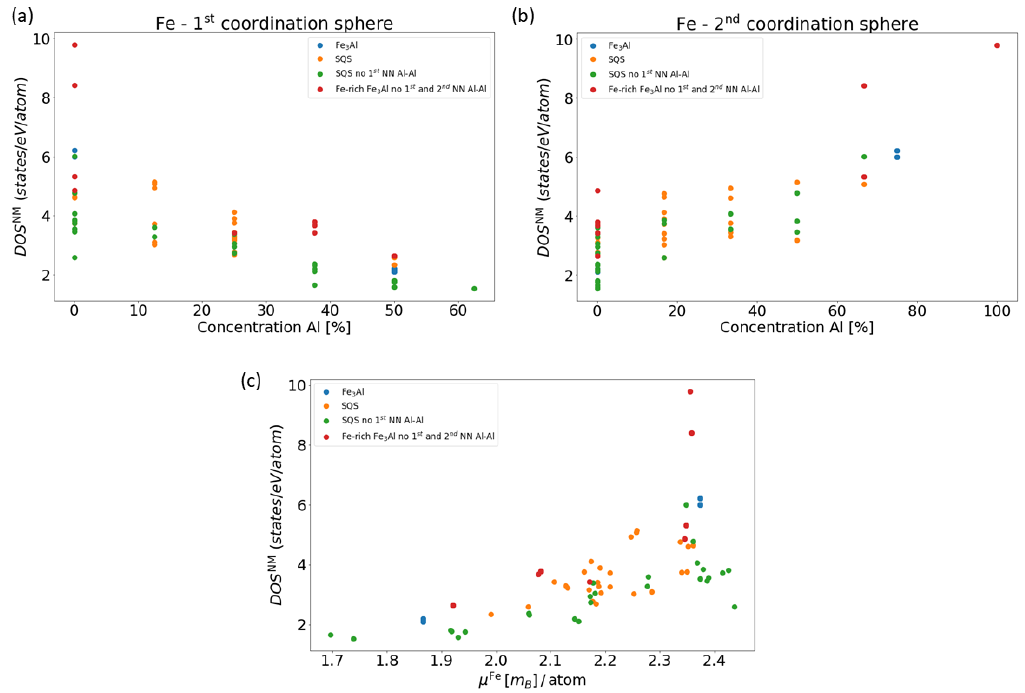
Figure 4. Calculated dependences of the density of states (DOS) of the Fe atoms at the Fermi level E F in the case of NM states as a function of the Al concentration in the 1st ( a ) and the 2nd ( b ) coordination shell, respectively. Part ( c ) shows the DOS of the Fe atoms at the E F in the case of NM states as a function of their local magnetic moments in the case of FM states.